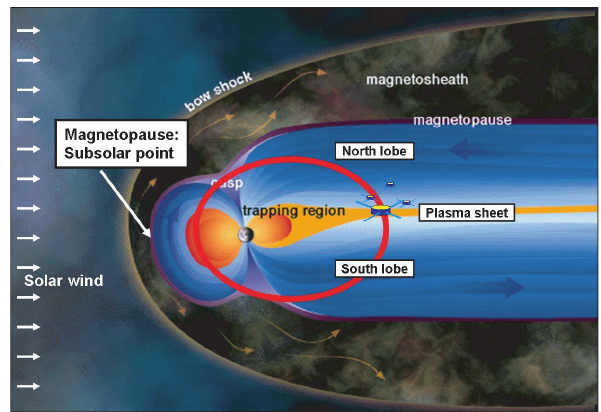
Fig. 1. A schematic view of the Cluster orbit when the apogee is in the magnetotail. Such orbits have occur during the summer season